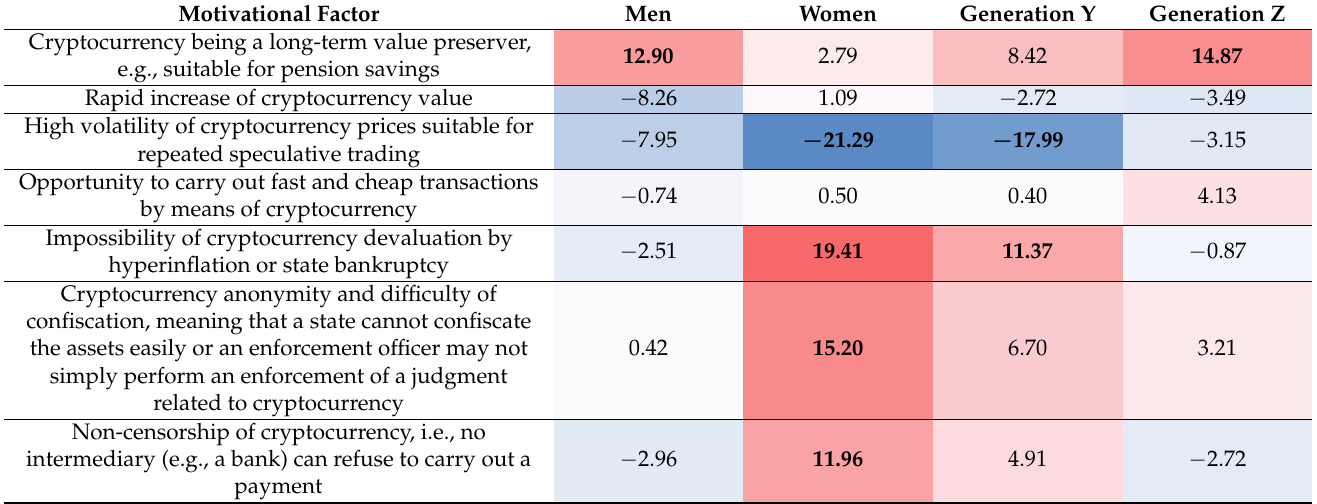
Table 6. The values below refer to the difference between respondents with and without a tendency to take risks in percentage points and to the given encouraging factor. Positive values refer to by how many more percentage points there are respondents with a tendency to take risks who are encouraged by the given factor, compared to those without such a tendency. A red-white-blue scale is selected for the entire table. Statistically significant values at the 5% significance are highlighted in